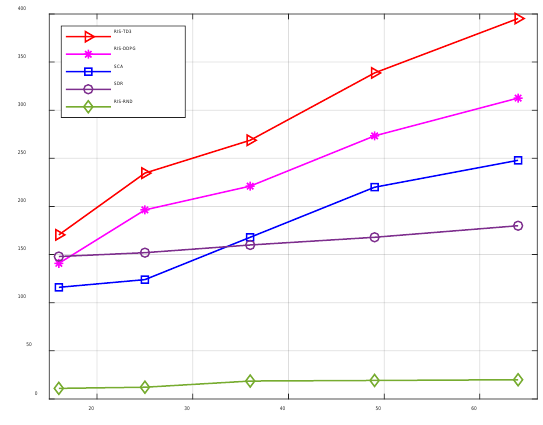
Figure 3. Median GRCD versus the number of antenna N at the reader with K = 4, Hidden_dim = 128.